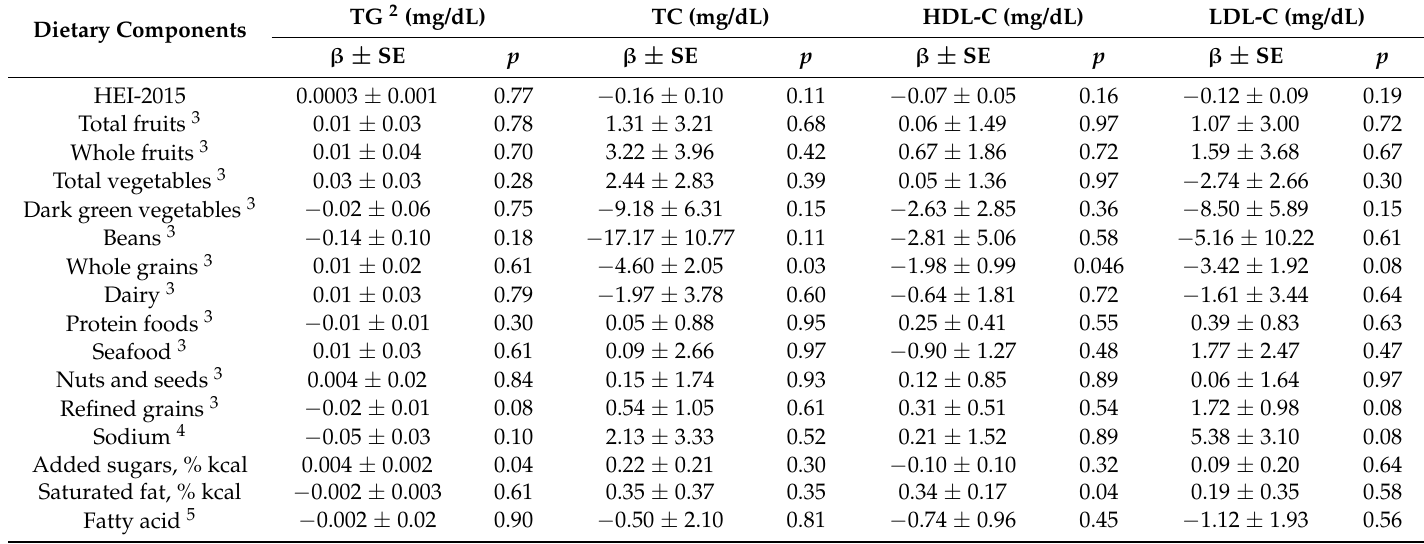
Table 3. Association of diet quality and food group and nutrient intake with serum lipids in youth with type 1 diabetes 1 . Dietary